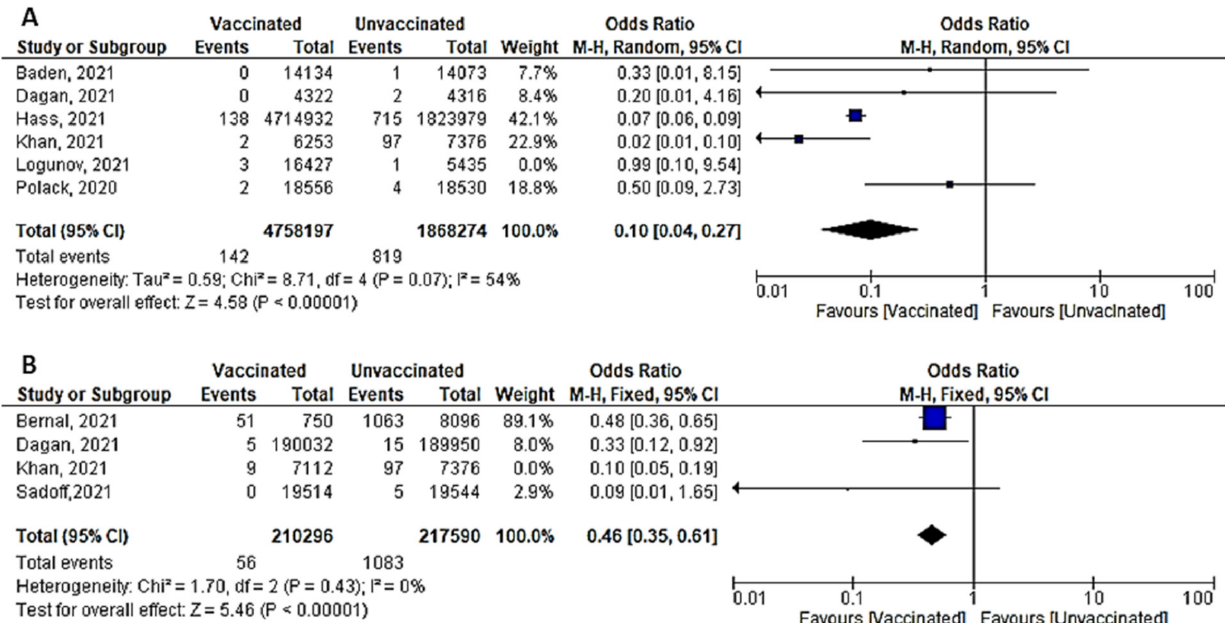
Figure 4. ( A ) Mortality 7 days after the 2nd dose of COVID-19 vaccination. ( B ) Mortality 14 days after 2nd dose of COVID-19